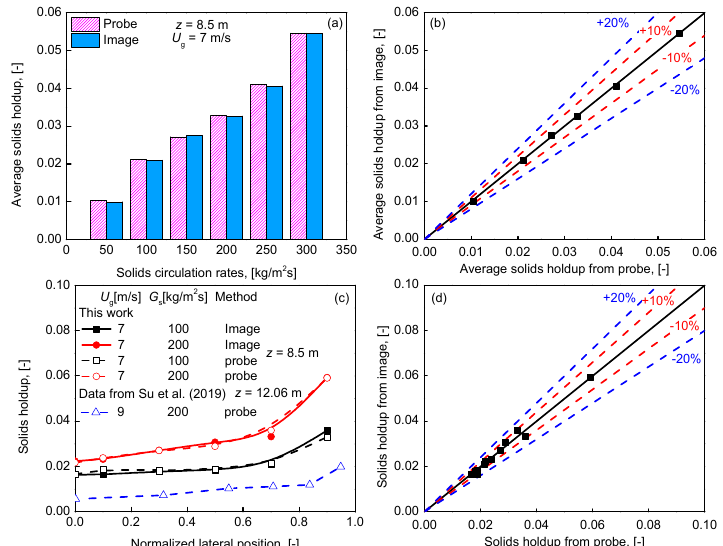
Figure 15. Solids holdup distribution based on image measurement in the gas-solids circulating fluidized bed with Group A particles. ( a ) Comparison of solids holdup between image and probe. ( b ) Comparison of error between image and probe in axial distribution. ( c ) Comparison of lateral distribution of solids holdup. ( d ) Comparison of error between image and probe in lateral distribution.